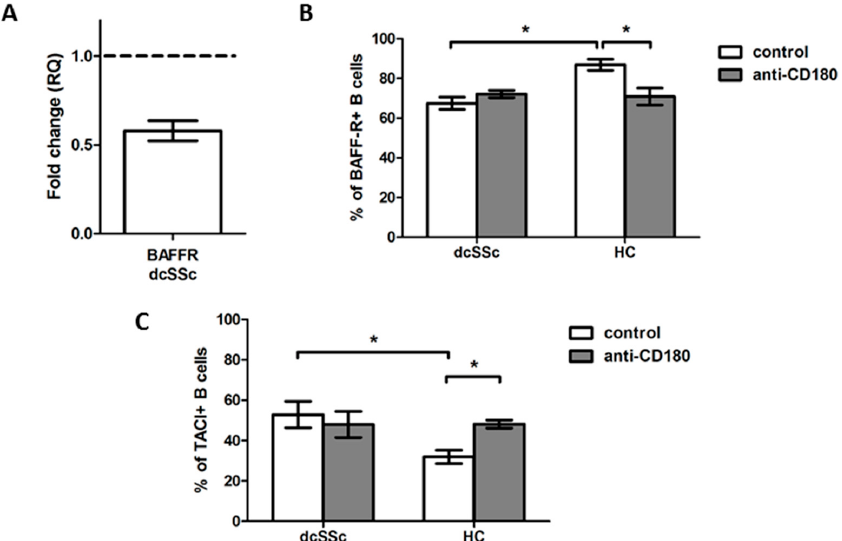
Figure 3. Analysis of BAFF-R and TACI expression in dcSSc and HC total B cells. ( A ) BAFF-R mRNA expression in total B cells of dcSSc patients ( n = 3) compared to HCs ( n = 3). Gene expression was normalized to HCs and the horizontal line (value 1) represents the expression of control samples. Changes in gene expression are shown as relative quantification (RQ) values. Data are shown as mean ± standard error of the mean (SEM). Alterations in the protein expression of BAFF-R ( B ) and TACI ( C ) in anti-CD180 antibody stimulated and unstimulated dcSSc ( n = 4) and HC ( n = 4) total B cells, as measured by flow cytometry. Data are presented as means ± SEM. * p < 0.05. 2.4. Basal Expression of BAFF-R Is Higher in HC Naive B Cells and Is Reduced by Anti-CD180